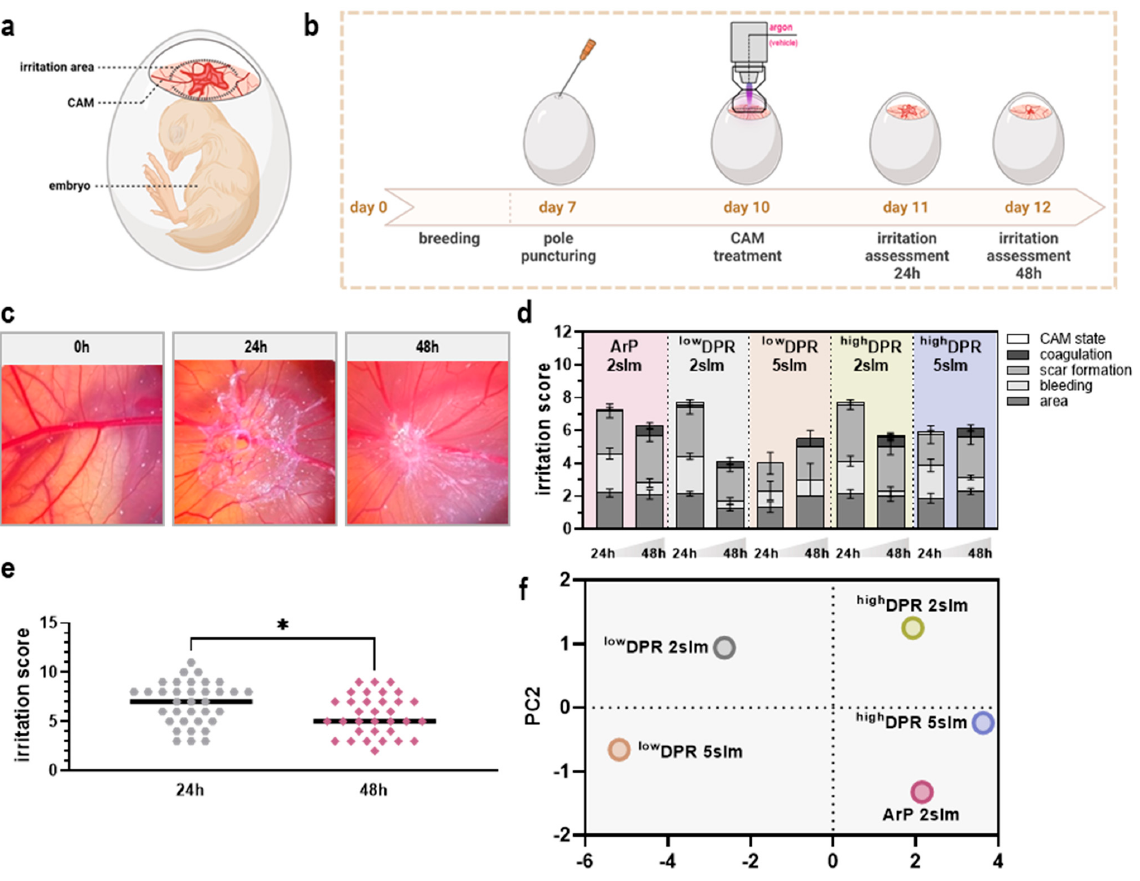
Figure 6. HET-CAM irritation assay after gas plasma treatment. ( a , b ) Schematic overview of the HET-CAM assay ( a ) and experimental procedure ( b ); ( c ) representative CAM irritations 24 h and 48 h after gas plasma exposure; ( d ) individual scores across all gas plasma groups and two assessment time points; ( e ) cumulative scores across all gas plasma treatment times after 24 h and 48